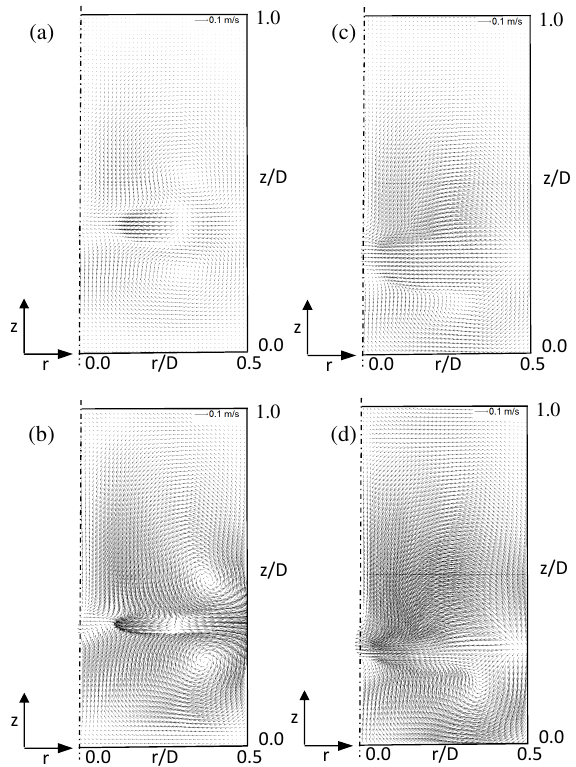
Fig. 8. Mean velocity field for h/H =1/3 and Rushton turbine (a,b), novel impeller (c,d) and rotational speed N =100 rpm (top), N =300 rpm (bottom).